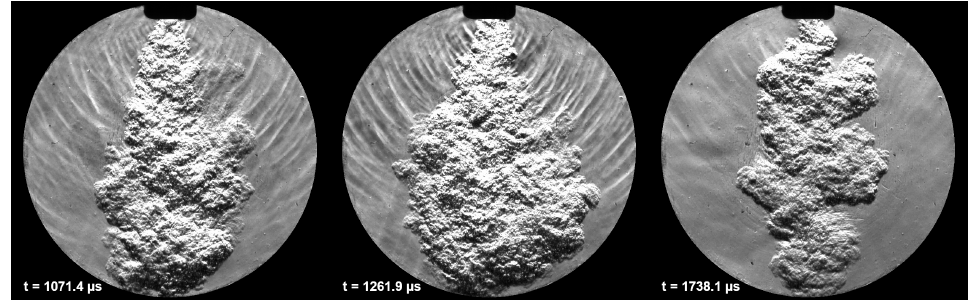
Figure 8. Comparison of spray images of the OsciJet nozzle when exceeding the visible range at different pressure ratios Π ; left : Π = 10, center : Π = 6, right : Π =